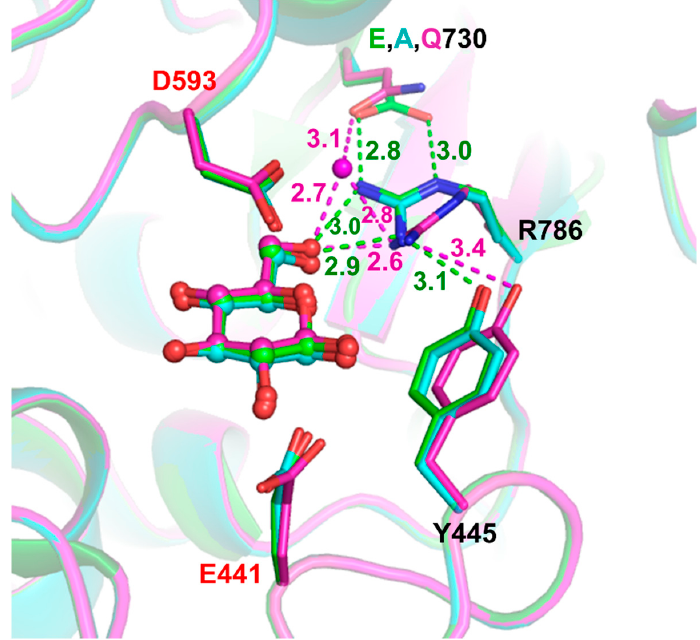
Figure 6. Structures of E730A (cyan) and E730Q (magenta) with glucose ligand. The glucose ligand molecules are positioned similar to that in the wild type (green, PDB: 5BX5 [17]). One water molecule that takes the position near that vacated by the R786 residue guanidinyl group in E730Q mutant is shown as a magenta ball. Hydrogen bonds and close polar contacts are shown as dashed lines with distances marked (green for wild type and magenta for E730Q).